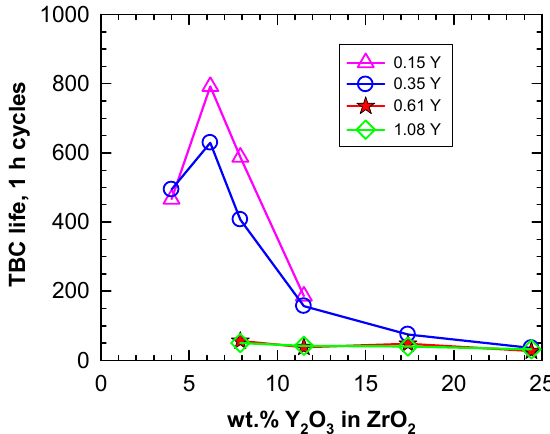
Figure 1. Thermal barrier coatings (TBC) life (time to first TBC crack) in 1200 ° C 1-h cyclic natural gas-O 2 torch rig test of air plasma sprayed (APS) yttria stabilized zirconia (YSZ) as a function of Y 2 O 3 content in YSZ for four Ni-16Cr-5Al-Y bond coats [6] (also presented in [9]).